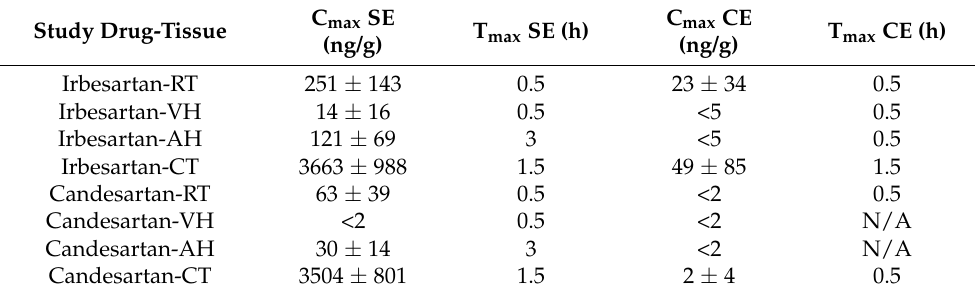
Table 1. C max after a single dose of 1.5% irbesartan or 0.15% candesartan calculated for the four analyzed tissues in the study (SE) and control eye (CE), RT: retinal(choroidal) tissue, VH: vitreous humor, AH: aqueous humor, CT: corneal tissue, N/A: concentrations in all samples at all timepoints were below the lower limit of quantification and therefore T max was not determinable. C max are shown as means ± SD.